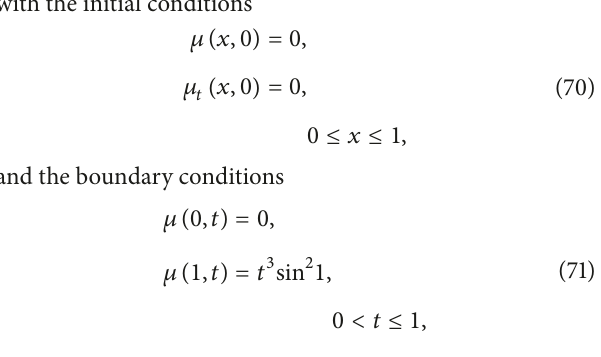
with the initial